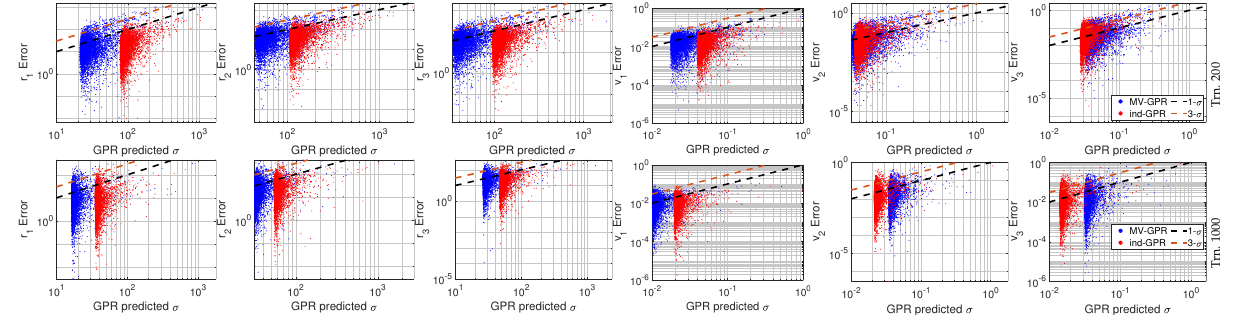
Figure 9. Predicted standard deviation versus the error between the predicted mean and the true Cartesian state given perfect RA and DEC measurements.